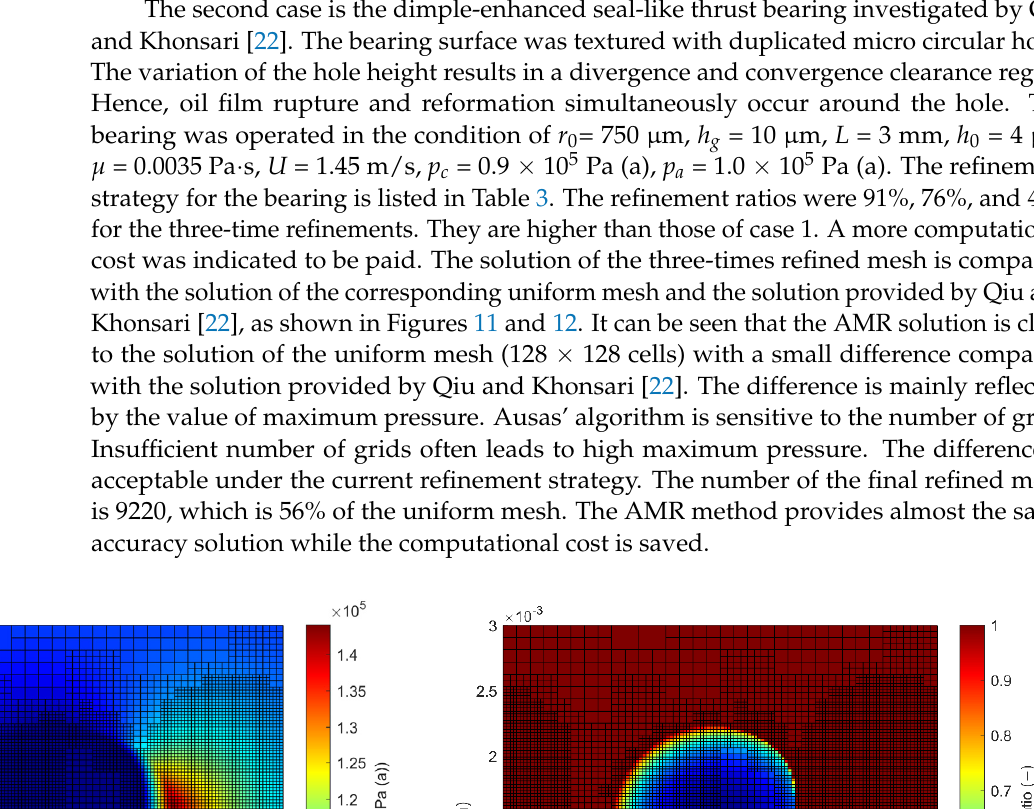
Figure 10. Comparison of pressure distribution between different results for y = 50 mm.